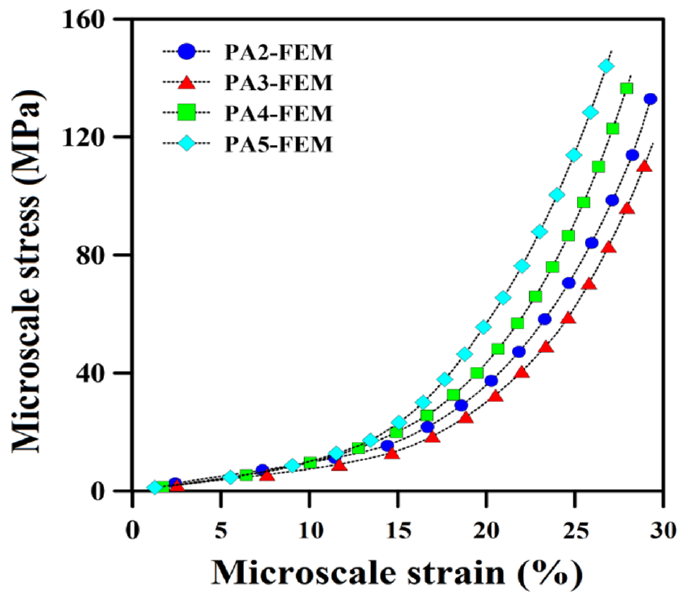
Figure 13. Micro-scale stress as a function of micro-scale strain for the POE foams.